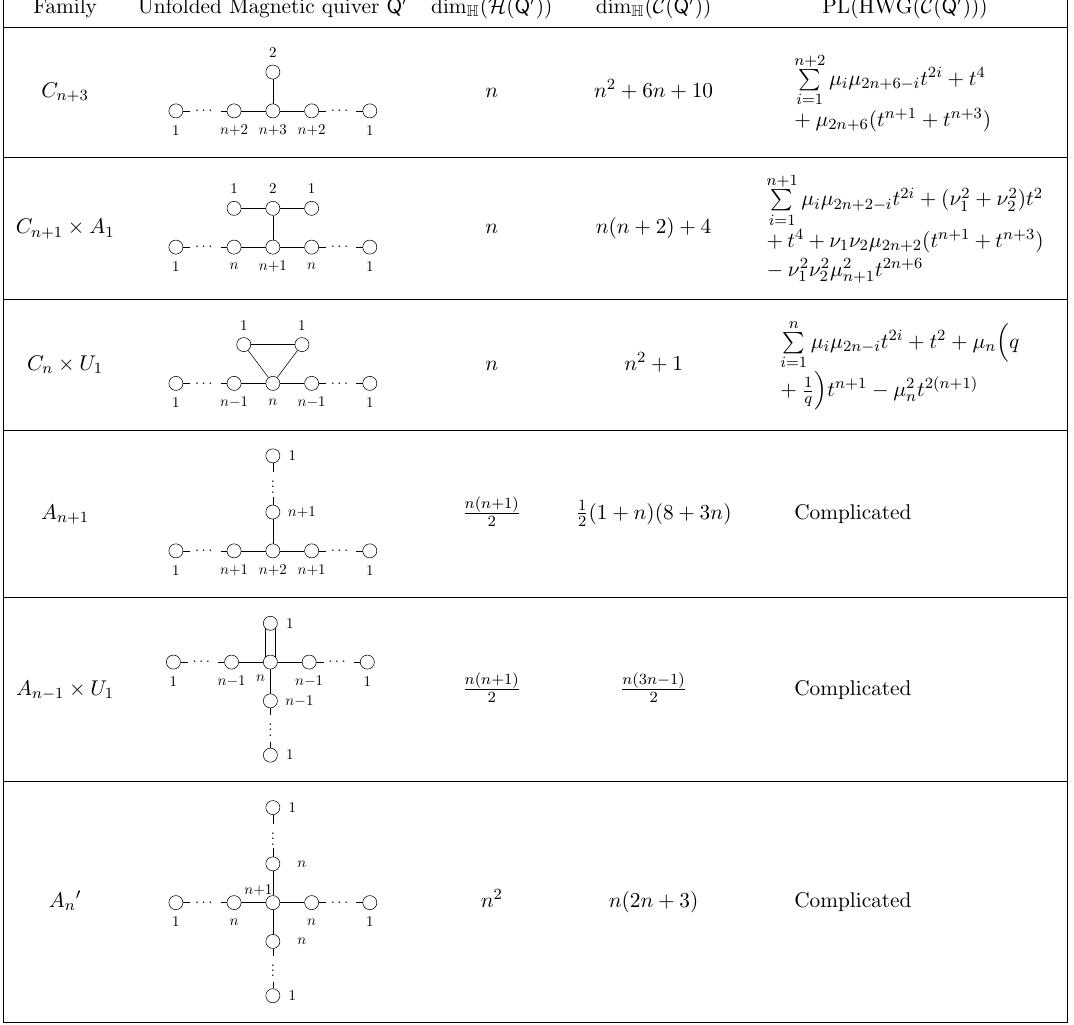
Table 10 . Magnetic quivers of 5 d = 1 theories. In the case of n = 2, folding these theories N reproduces the magnetic quivers of 4 d = 2 theories of table 2. We provide the dimension of both N the Higgs branch ( Q 0 ) and the Coulomb branch ( Q 0 ) of the unfolded magnetic quivers. The H C HWGs are given in [12, 57]. The prime in the label of the last family is to distinguish it from the fourth